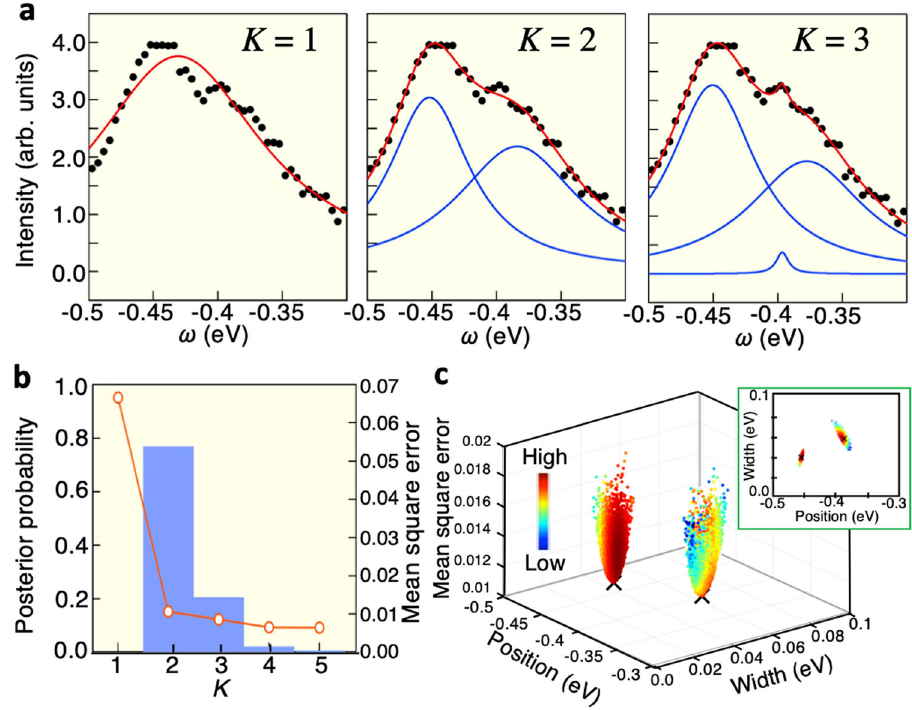
Fig. 1 Application of Bayesian analysis to the energy distribution curve. a Numerical fi ttings (red curves) to a typical energy distribution curve (EDC; black dots) assuming the existence of single, double, or triple intrinsic Lorentzian peaks (blue curves). A hyper-parameter K represents the number of peaks. b Plot of mean square error (red open circles) and posterior probability (blue rectangles) against K that supports the existence of two peaks in the EDC. c Density scatter plot of the posterior probability distribution in the Bayesian analysis (color dots), compared with the least-squares solution (black crosses). Inset shows the posterior probability distribution as a projection in the direction of mean square